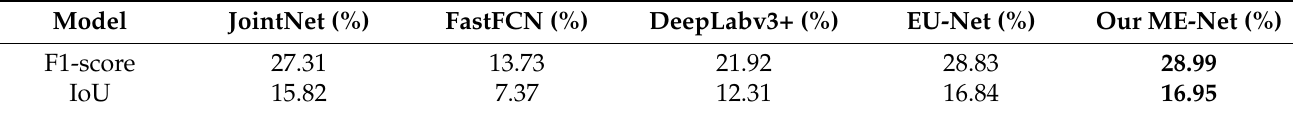
Table 6. Building edge detection results on the Massachusetts test set in terms of F1-score and IoU, the best values are masked as